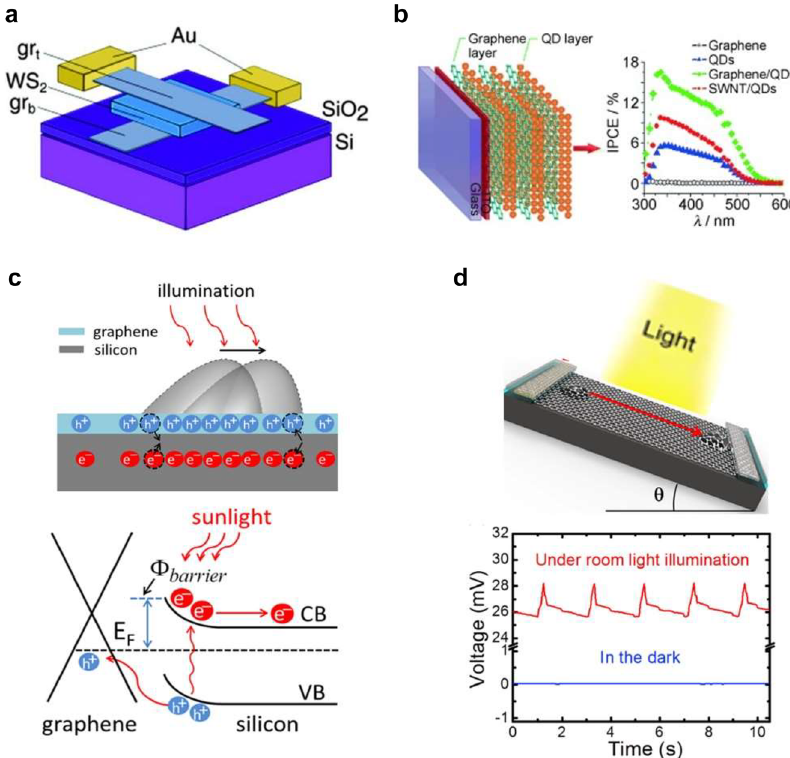
[123], Panel (c) and (d) adapted with permission from